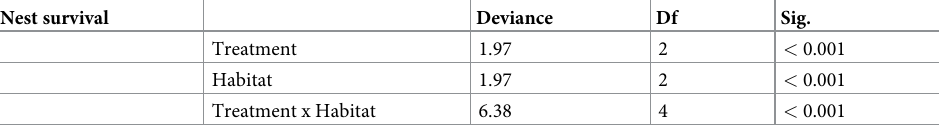
Table 3. General Linear Model using log(x+10) transformed estimated nest survival as response variable: Factor effects shown (N = 107 nests).